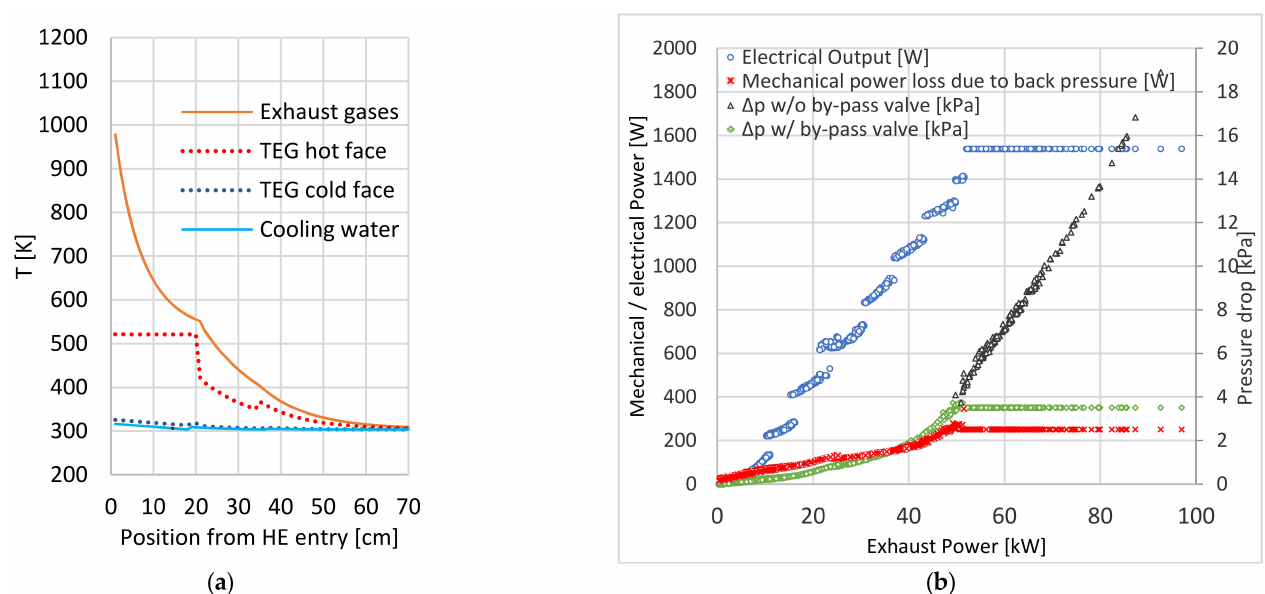
Figure 13. ( a ) Temperature profile of the exhaust, cooling water, and TEG faces for an average exhaust power setting (instant 219 s of the HW driving cycle); ( b ) Electric power produced, pressure drop, and engine power loss due to back pressure caused by the generator (HW cycle). Adapted from